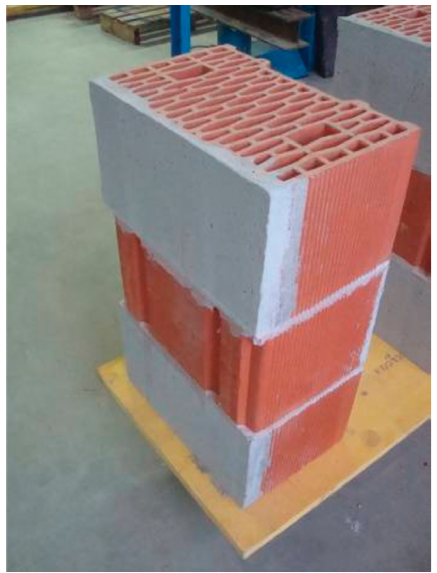
Figure 15: Specimen constituted by three